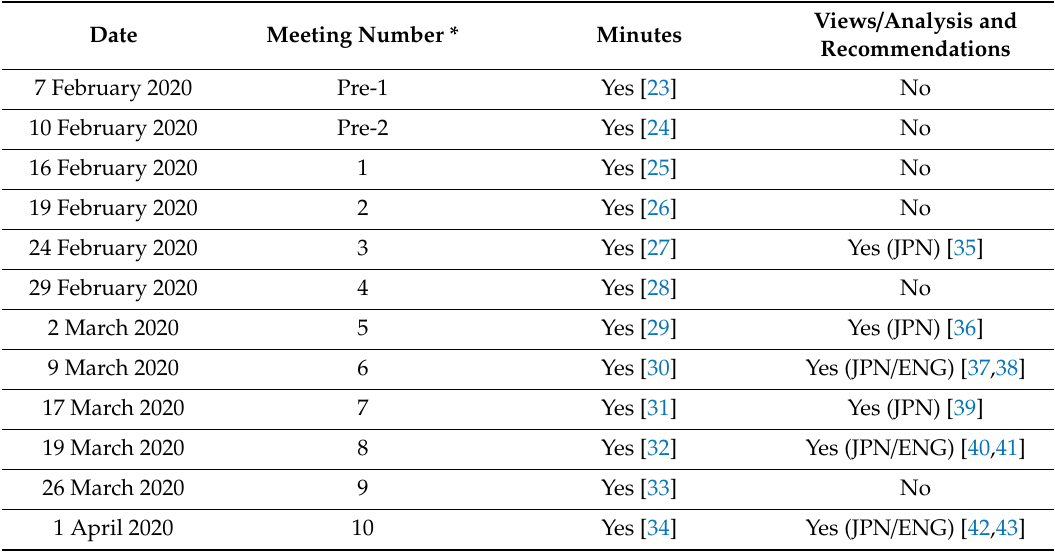
Table 4. Novel coronavirus expert meetings in Japan, before 7 April